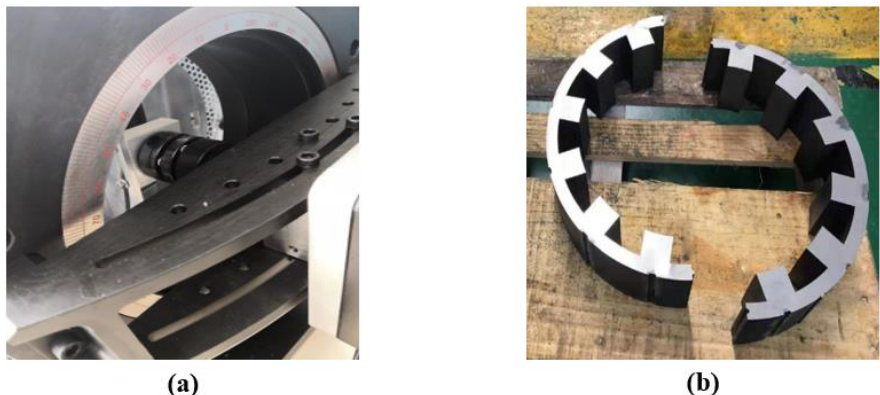
Figure 21. Parts diagram of DDSRG. ( a ) Generator deflection scale disc. ( b ) Stator structure.